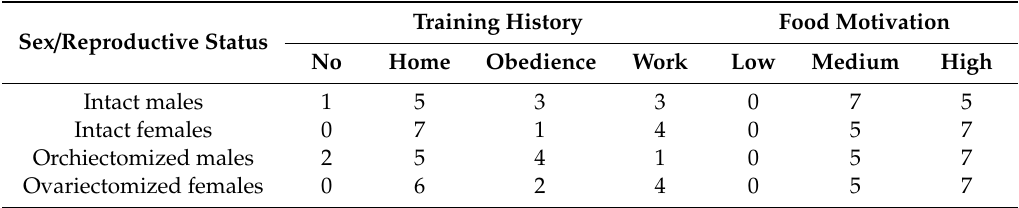
Table 1. Distribution of categories of Training history and Food motivation within groups of dogs of di ff erent sex and reproductive status. Training History Food Motivation Sex / Reproductive Status No Home Obedience Work Low Medium